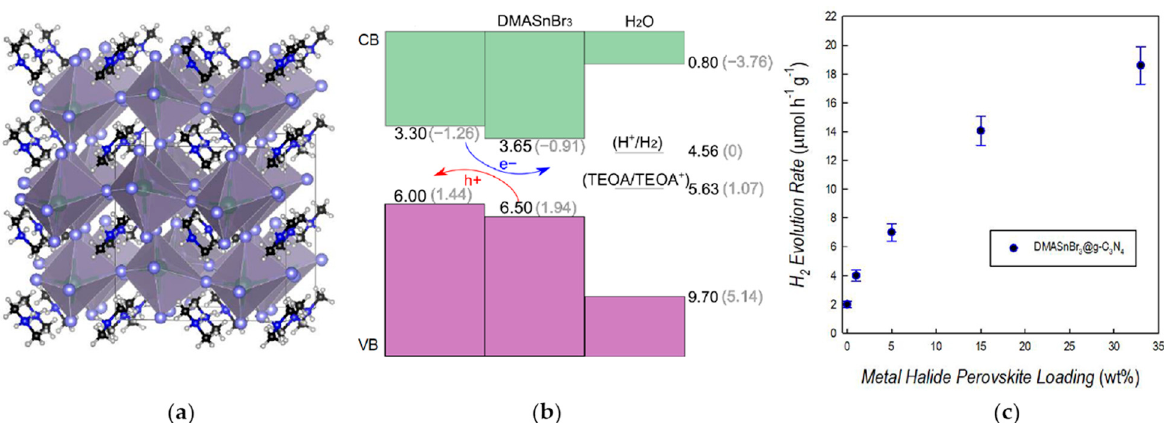
Figure 4. ( a ) Schematic representation of DMASnBr 3 crystal structure, ( b ) valence band (VB) to conduction band (CB) edges of g-C 3 N 4 and DMASnBr 3 aligned with the band edges of liquid water and with the H + /H 2 and triethanolamine (TEOA)/TEOA + redox level through the vacuum level. Values (eV) are referred to the vacuum level (black) and to the standard H 2 electrode (SHE, grey), ( c ) H 2 evolution rates for DMASnBr 3 @g-C 3 N 4 composites at different percentages of MHP loading in 10% v / v TEOA aqueous solution. Reproduced from [17], with permission from Whiley, 2020.